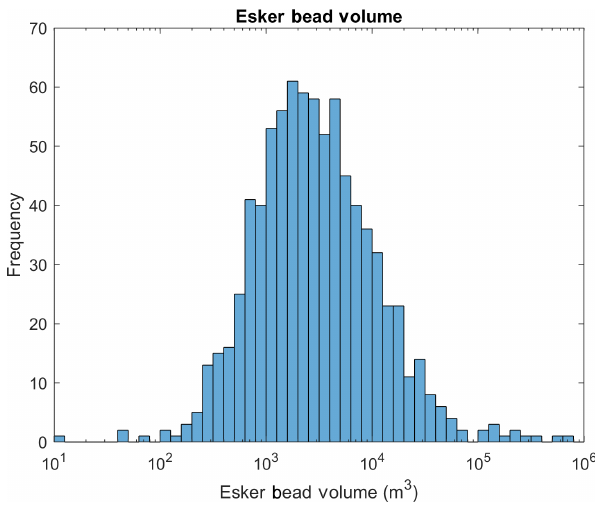
Figure 10. Esker bead volume. Because the beads are interpreted as quasi-annual and the lateral spacing of the eskers is thought to re- flect the true spacing of the subglacial conduits, these volumes rep- resent a minimum sediment flux per year per 6–10km ice-margin